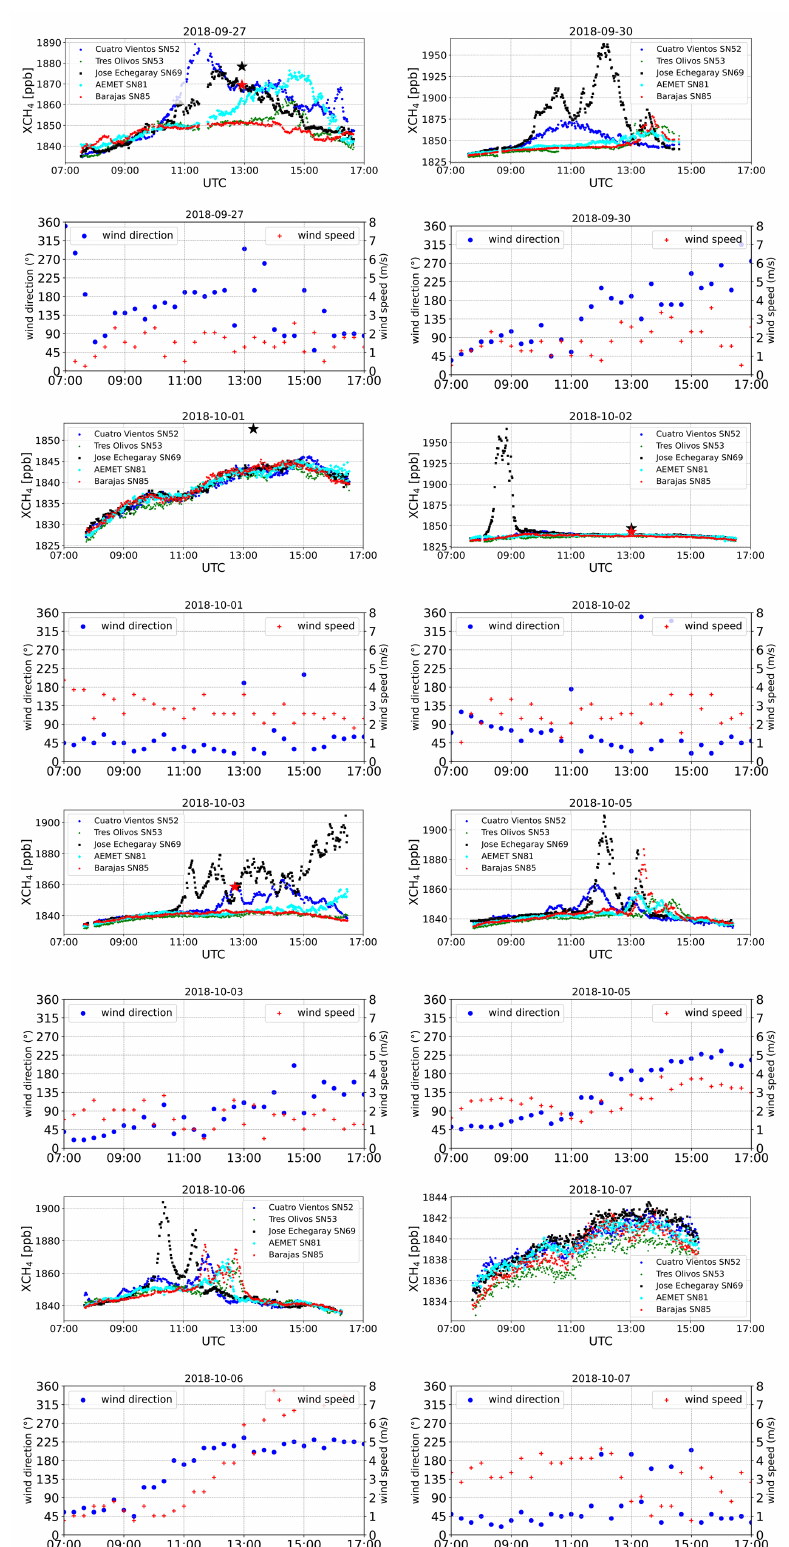
Figure A2. Time series of COCCON measurements at five stations and corresponding time series of wind fields (direction and speed) measured at the Cuatro Vientos Airport on 8d during MEGEI-MAD campaign in 2018. Star symbols represent the TROPOMI observations within a radius of 5km around each